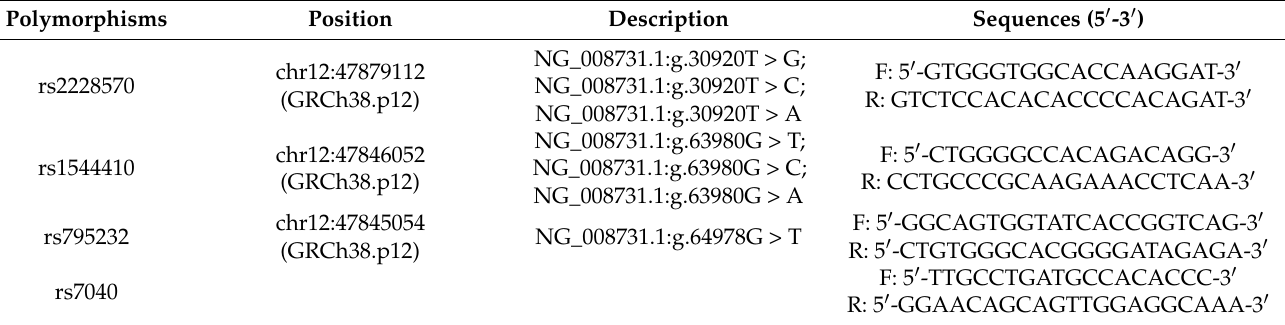
Table 1. Primer sequences.